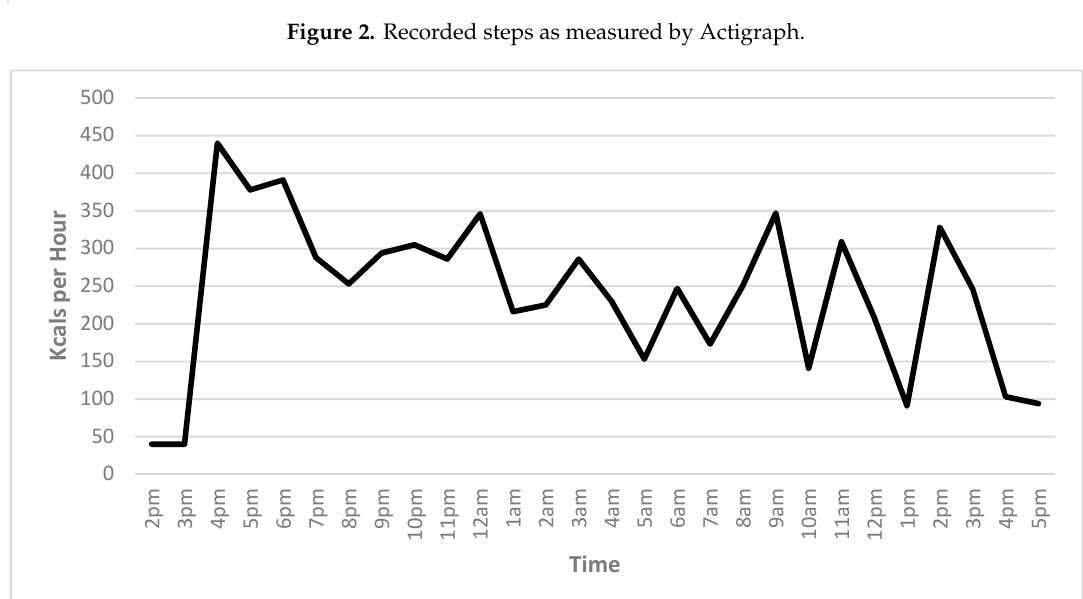
Figure 3. Rate of energy utilization over time.